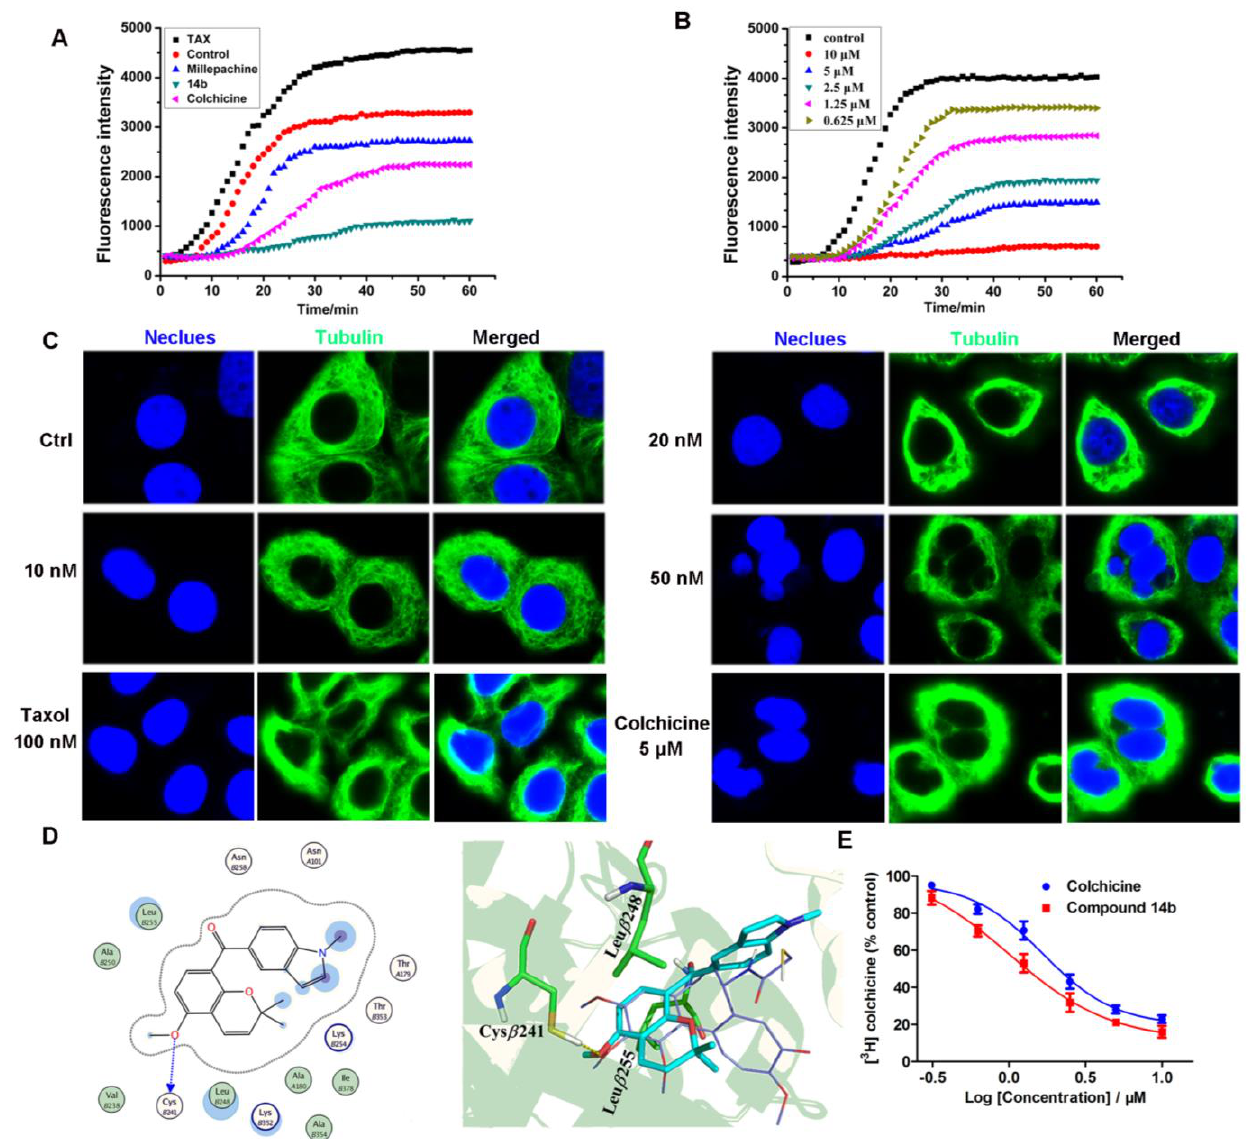
Figure 2. Effect of compound 14b on tubulin. ( A , B ) In vitro tubulin polymerization assay of compound 14b (5 μM ), paclitaxel (TAX, 5 μM ), colchicine (5 μM ) and millepachine (5 μM ). ( C )